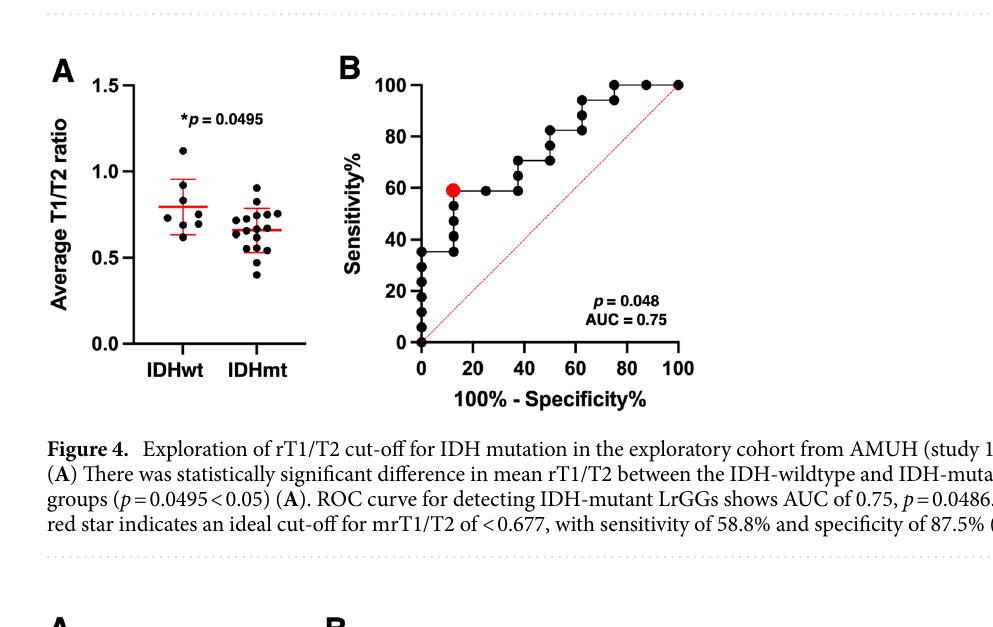
Figure 3. Voxel-wise comparisons between rT1/T2 and each of T1- and T2-relaxation times, according to reanalysis of data published previously (the reanalyzed cohort) 16 . The data consisted of 114,465 voxels from eight patients. T1- and T2-relaxation times both exhibited strong exponential correlations with rT1/T2 (A and B). Voxels in IDHwt tumors (26,969 voxels) showed significantly higher rT1/T2 than those in IDHmt tumors (87,496 voxels) (median value = 1.06 vs. 0.73, p < 0.0001) (C) 16 .